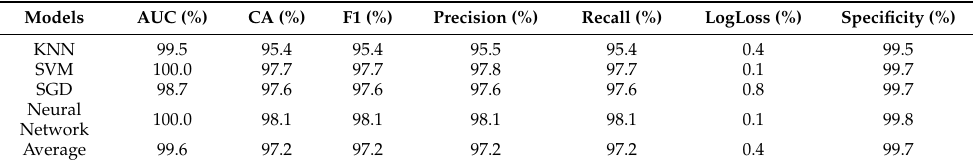
Table 3. Evaluation results for Lateral Sensor (T1) data using the K-Means Clustering Method (KMCM).